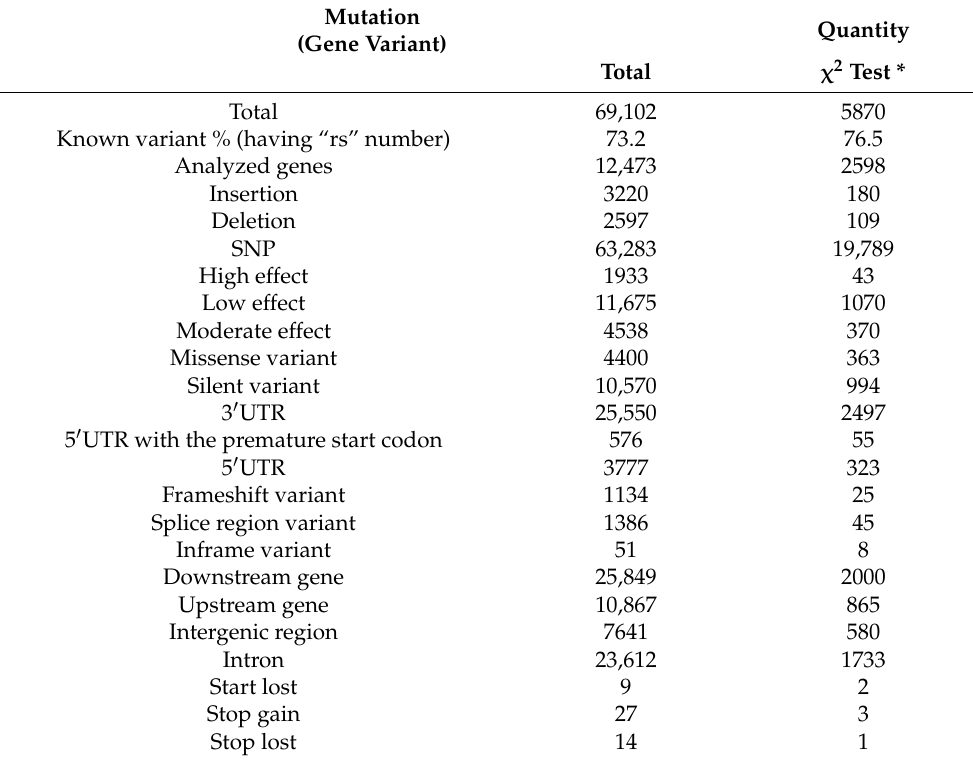
Table 1. Variant calling results generated based on subcutaneous fat transcriptome